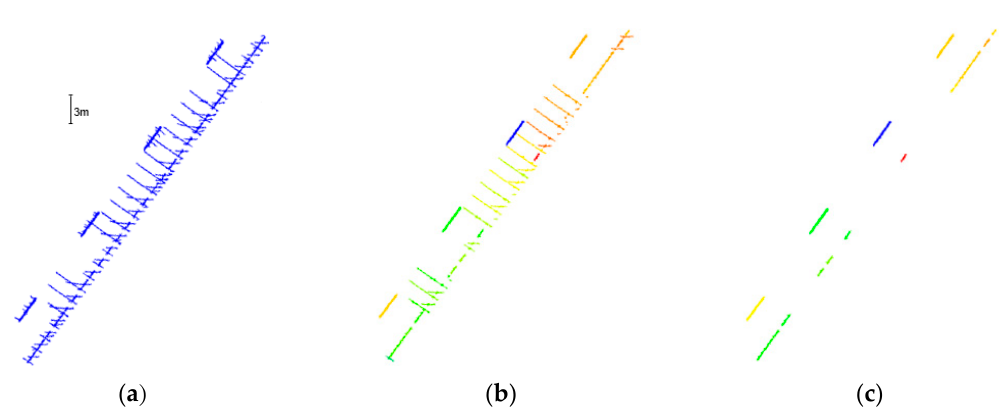
Figure 15. Illustrations of ( a ) hypothesized lane marking segments, ( b ) segments after RANSAC-based noise removal, and ( c ) segments after trajectory-based noise removal.